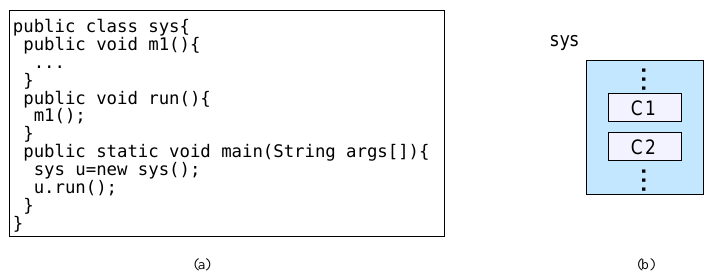
Figure 6. ( a ) Class nesting, object composition and object aggregation, ( b ) block diagram.